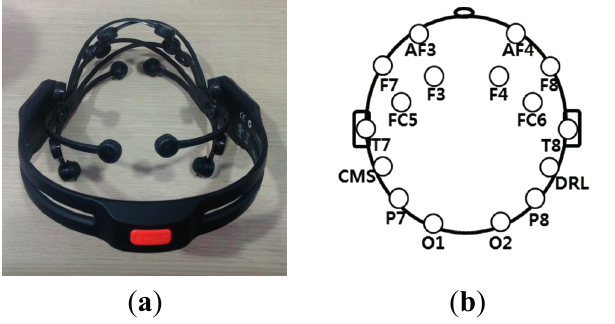
Figure 4. Commercial EEG device and locations of 16 electrodes based on the international 10–20 system. ( a ) Emotiv EPOC headset; ( b ) positions of 16